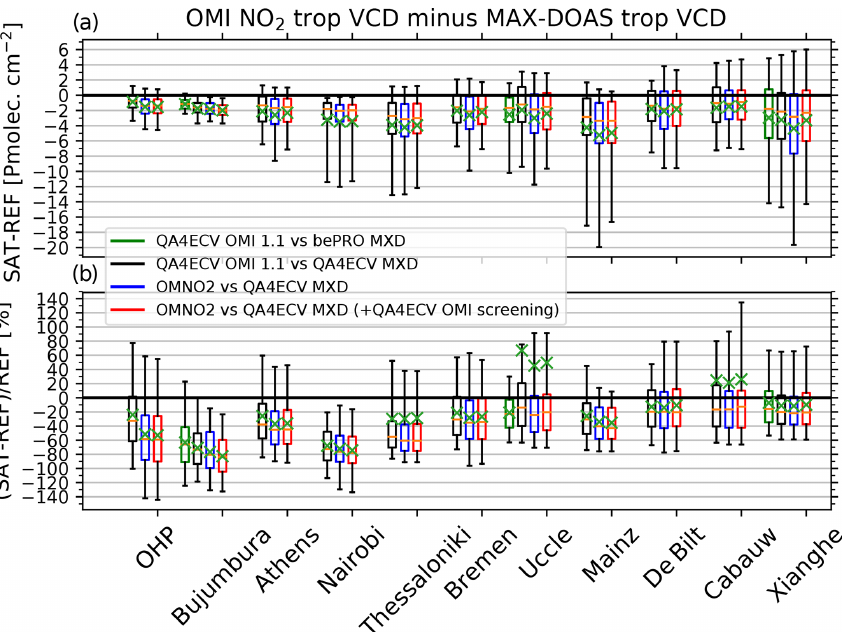
Figure 9. Boxplots for each site showing QA4ECV OMI NO 2 vs. QA4ECV MAX-DOAS (black boxes), QA4ECV OMI NO 2 vs. bePRO MAX-DOAS (green boxes, only for three sites), OMNO2 vs. QA4ECV MAX-DOAS (blue boxes) and OMNO2 vs. QA4ECV MAX-DOAS, but for the subset of OMNO2 pixels where QA4ECV OMI has an accepted pixel only (red boxes). Panel (a) displays boxplots of SAT–REF tropospheric VCD differences, and panel (b) displays boxplots of (SAT–REF)/REF. The same boxplot conventions are used as in Fig. 3. Outlying mean relative differences (green crosses) can occur when low REF values are